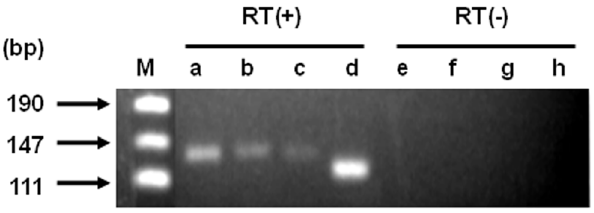
Figure 6. RT-PCR analysis in S.pneumoniae R6. One ng total RNA was used for the template for one reaction of RT-PCR, and the reaction was repeated for 24 cycles. pUC19 digested with Msp I was used as a size marker (lane M). pdrM (lane a, e), spr1756 (lane b, f), spr1877 (lane c, g). The expression of the atpB was used as an internal control (lane d, h). Reverse transcriptional reactions were submitted on samples in lane a, b, c, and d, and were not on samples in lane e, f, g, and h.